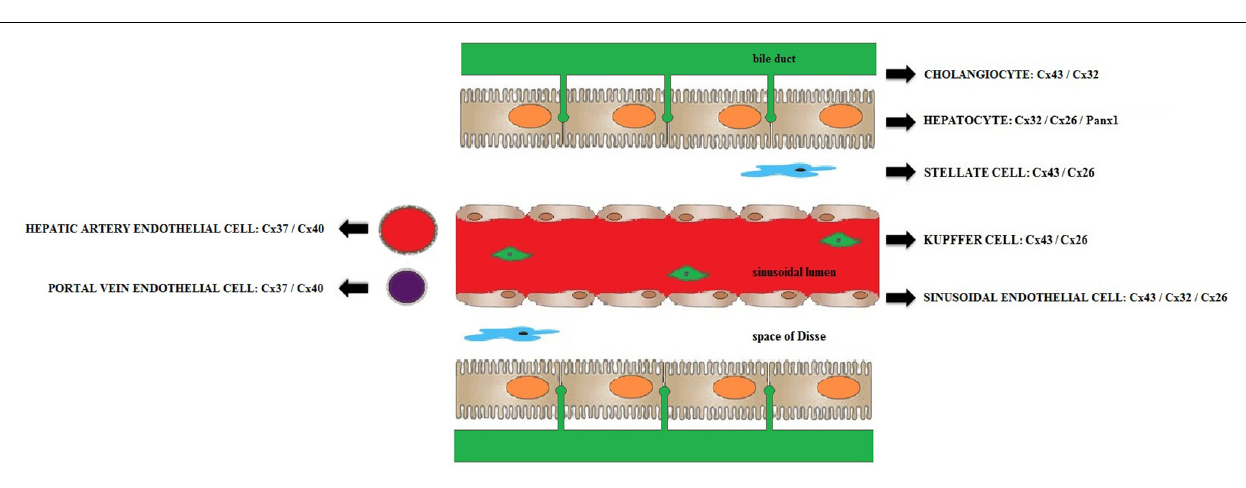
FIGURE 2 | Connexins and pannexins expressed in the liver. Schematic overview of the most relevant connexin and pannexin species expressed in rodent and human livers (Kumar and Gilula,